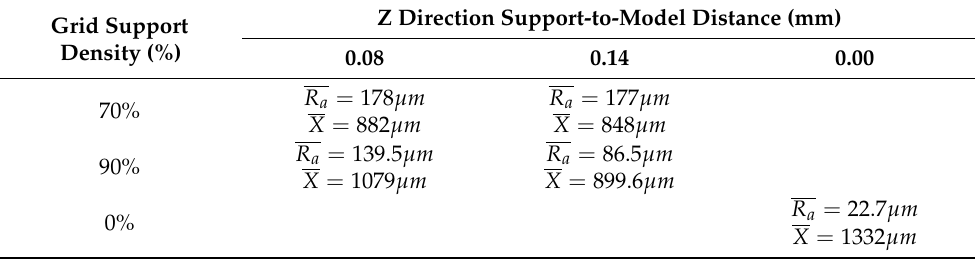
Table 5. Measurement results for two adjacent gratings of unsupported printing members and printing members with grid support under different conditions.